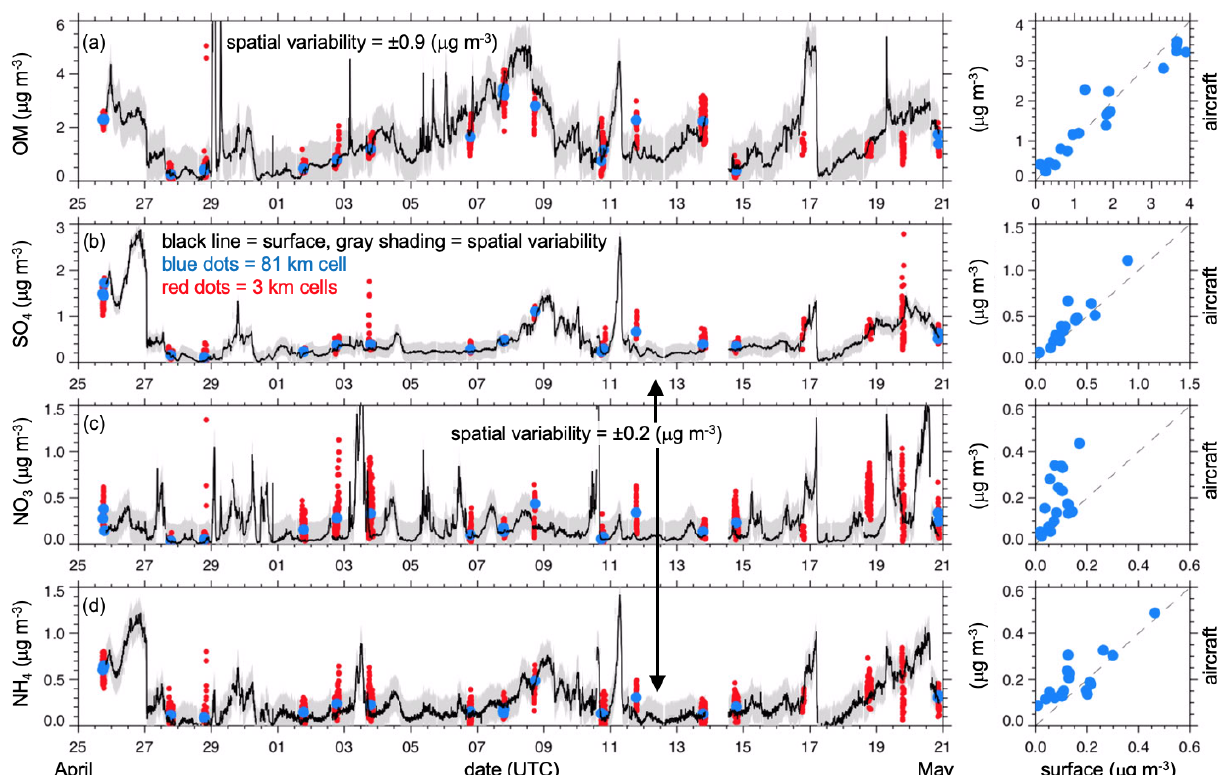
Figure 11. Measured (a) OM, (b) SO 4 , (c) NO 3 , and (d) NH 4 at the surface SGP site during IOP 1 (black lines), along with aircraft 81km cell averages within the boundary-layer (blue dots) and 3km cell averages (red dots) with the 81km cell over the SGP site. The right-hand-side panels compare coincident-in-time surface and aircraft measurements.